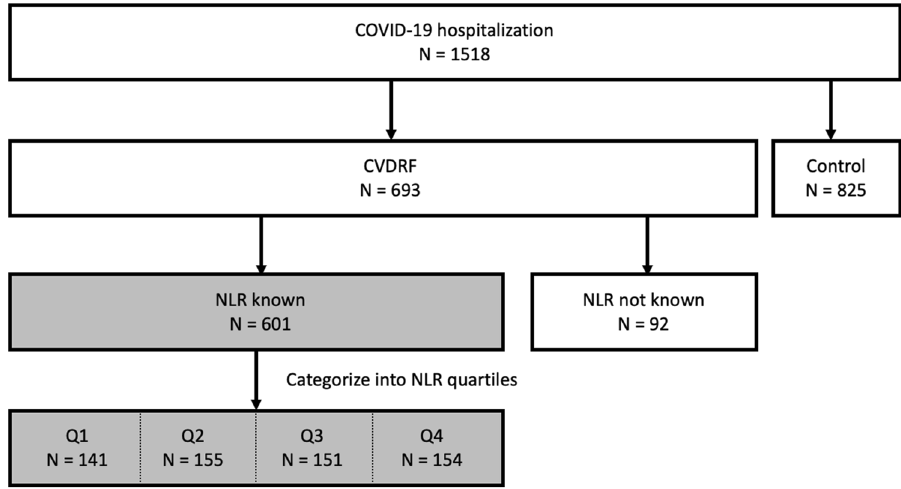
Figure 1. Study population. Patients included in the analysis are in the shaded boxes, N = 601. Q1–Q4 correspond to quartiles of the baseline